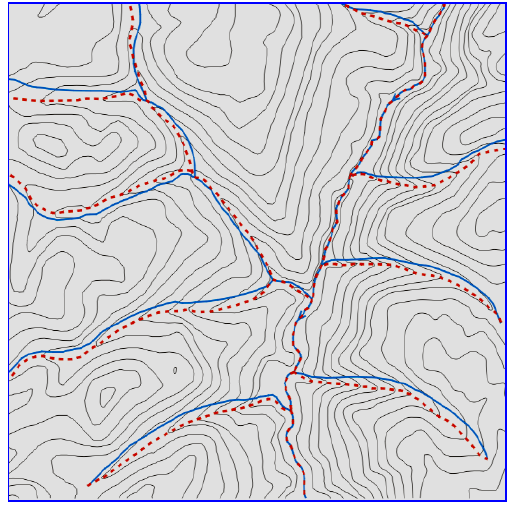
Figure 10. Displacement of river network to match contour